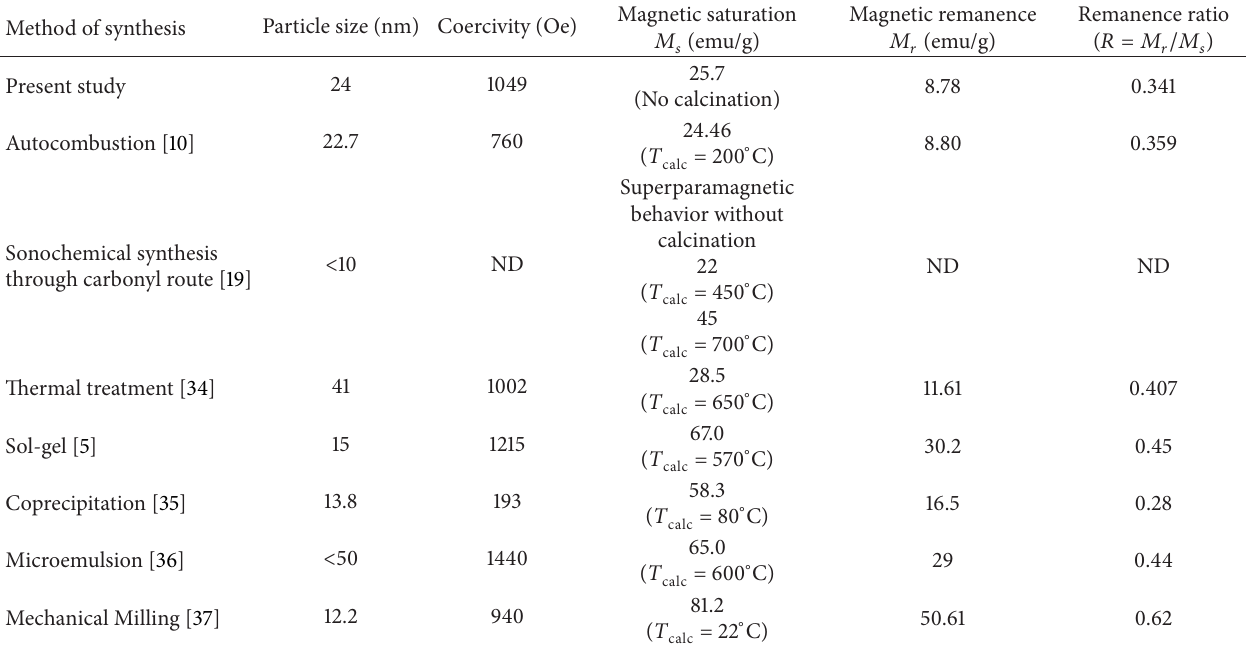
Table 1: Characterization of cobalt ferrite nanoparticles and comparison with the literature. Method of